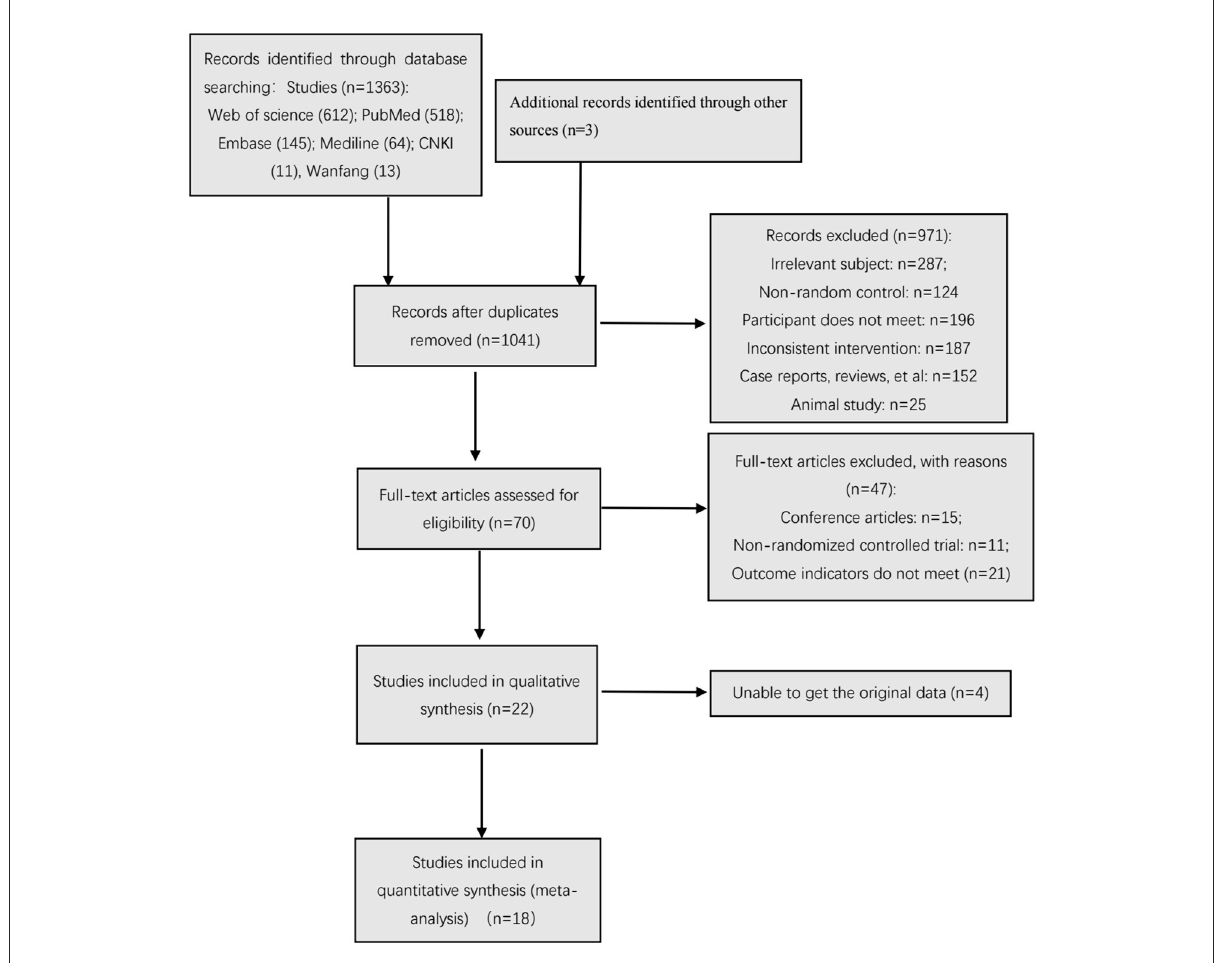
FIGURE1 Flow chart of the search